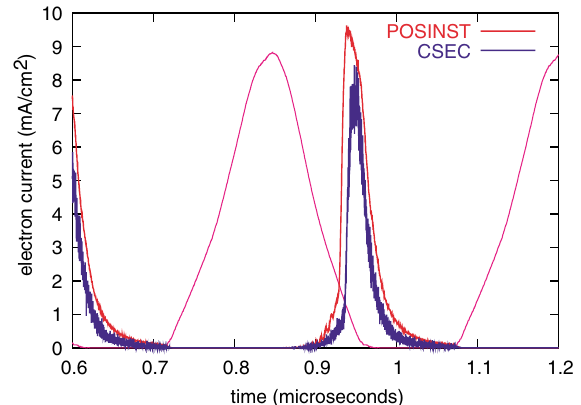
FIG. 8. (Color) SNS line charge densities for the beam and electron cloud within r (cid:5) (cid:26) for each of the six secondary yield curves in Fig. 5.